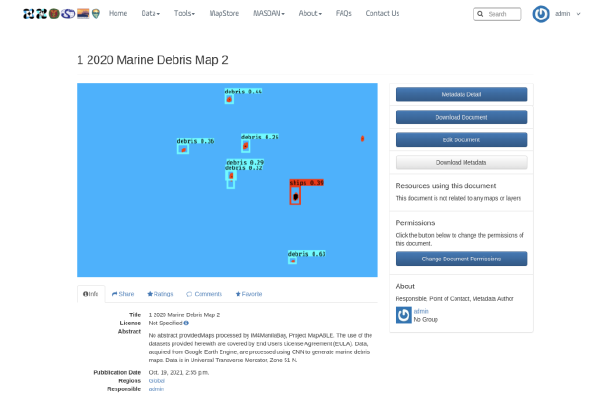
Figure 9. 2020 Marine debris map. Data acquired from Google Earth Engine (GEE) are processed using convolutional neural networks (CNN) to generate marine debris maps.